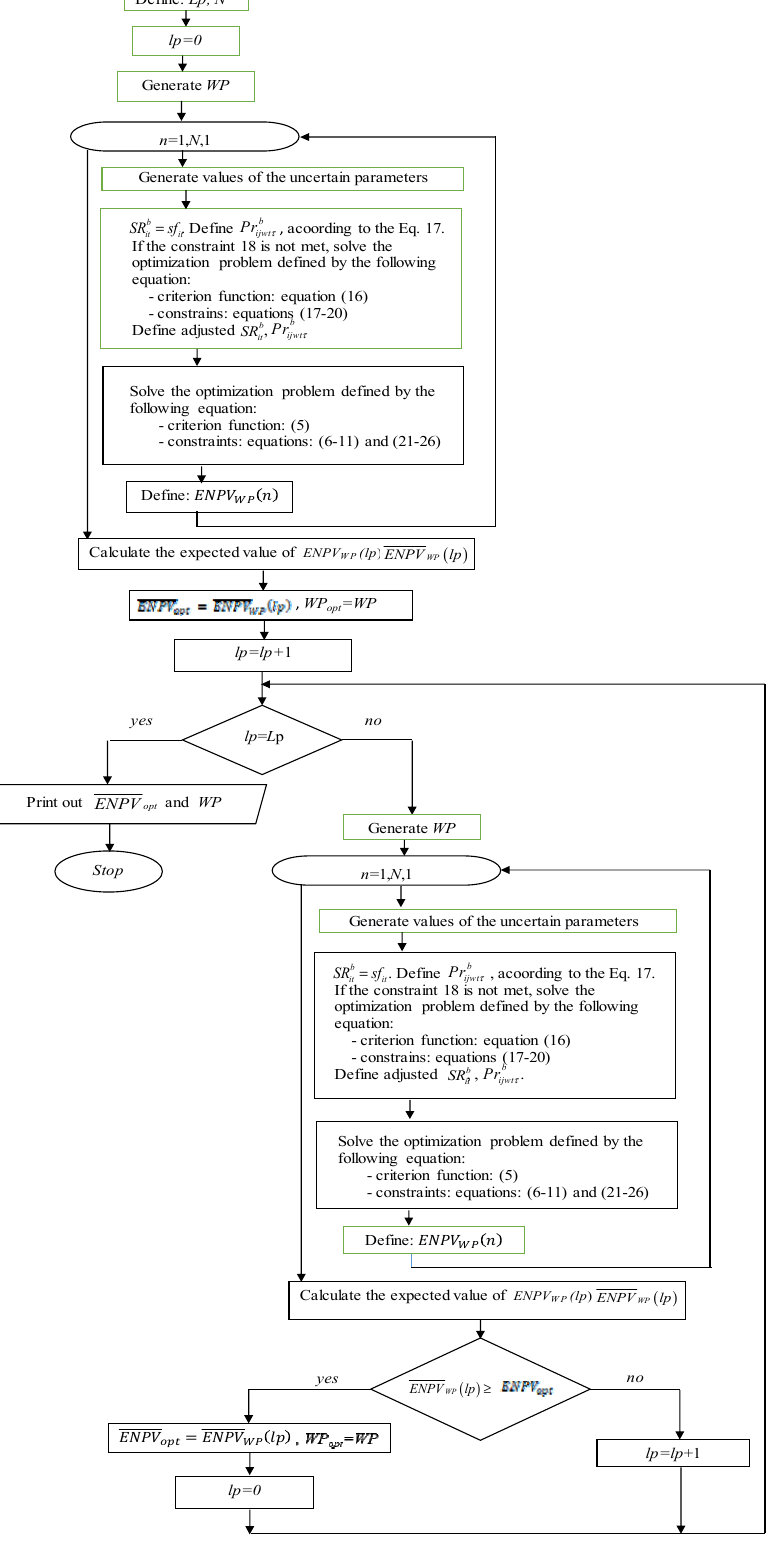
Fig. 2. The algorithm for selecting optimal value of portfolio of real